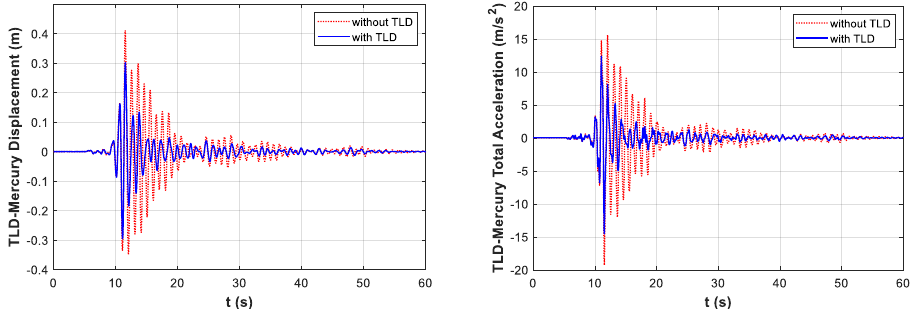
Figure 13. AHS optimization of the 10-story structure displacement – time and total acceleration – time graphs in the DUZCE/BOL090 earthquake record for TLD – mercury.